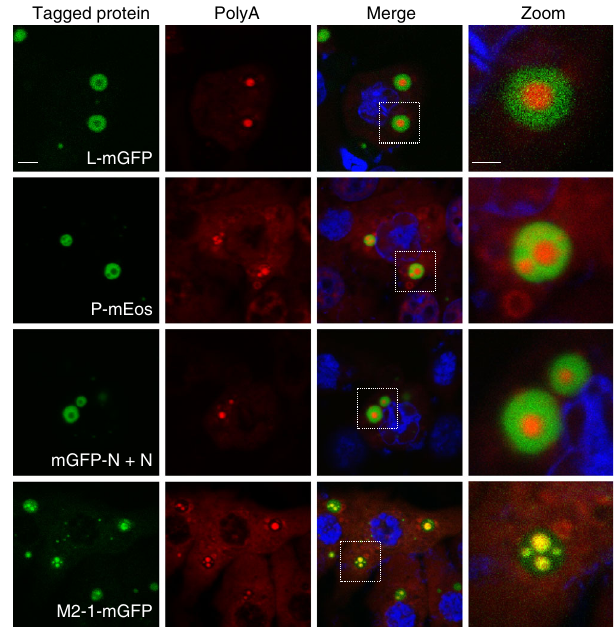
Fig. 4 Localization of the N, P, L and M2-1 proteins inside transiently reconstituted IBs. BSRT7/5 cells were transfected with plasmids encoding the N, P, L and M2-1 proteins and the M/Luc subgenomic minireplicon. Tagged protein was expressed instead of the corresponding wild type as indicated on the pictures. For N protein, the plasmids encoding wild type and tagged protein were mixed in equivalent ratio when indicated mGFP-N + N. FISH analyses were performed to detect poly(A) RNA (in red ) and were stained with Hoechst 33258 (merge). The expressed tagged proteins are visualized thanks to their spontaneous green fl uorescence in the fi rst column. Representative images from three independent experiments are shown. Images were taken under a Leica SP8 confocal microscope. Scale bar 5 µ m. The boxed areas enclose IBs that are shown magni fi ed in the fourth column, scale bar 2 µ